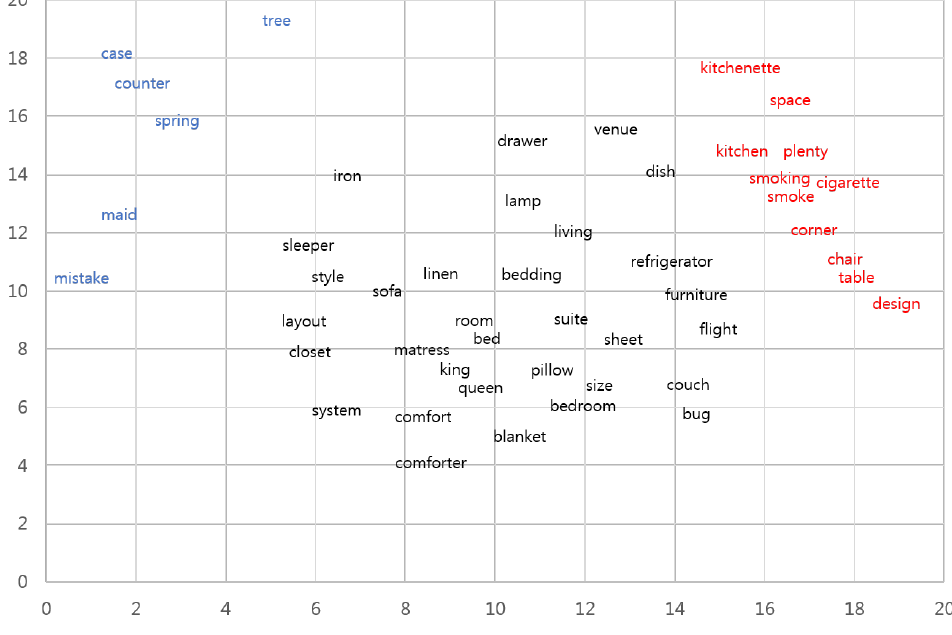
Figure 5. A clustering result of